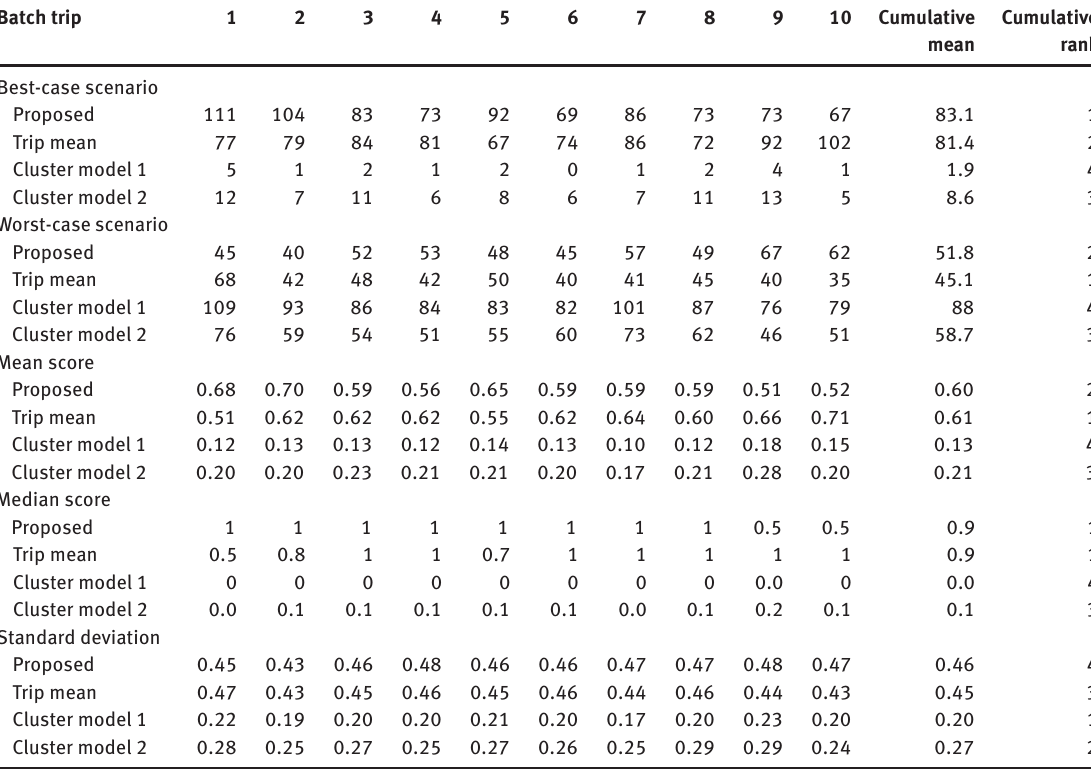
Table 3: Statistical Report on Trip Planning Models for 10%